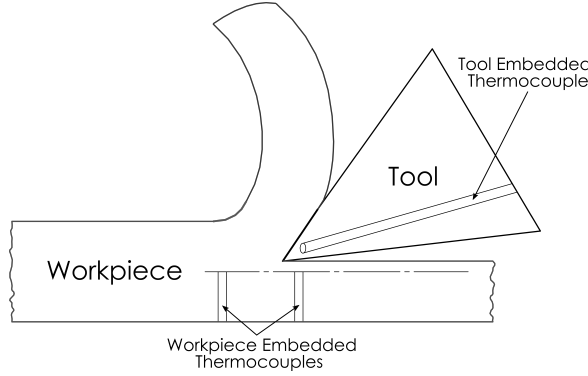
Figure 4. An illustration of tool- and workpiece-embedded thermocouple